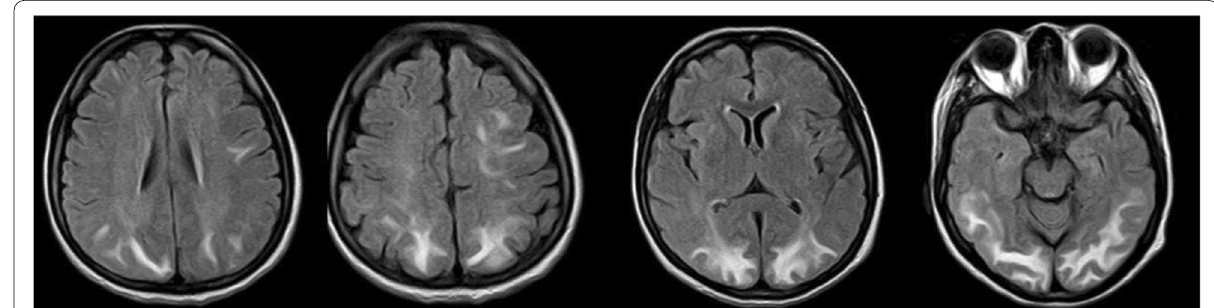
Fig. 1 MRI of case 1 on day 12. The parietal, temporal, and occipital lobes exhibited index finger-like abnormality, long T1, long T2, high FLAIR signal, and fuzzy